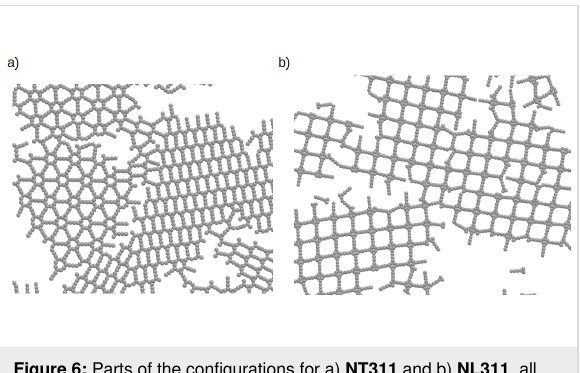
Figure 6: Parts of the configurations for a) NT311 and b) NL311 , all with ρ * = 0.2 at T * =